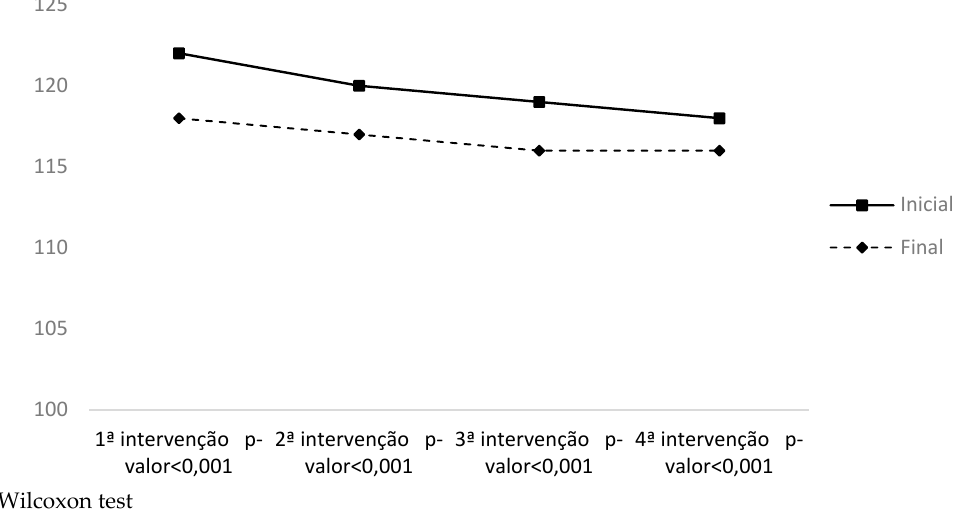
Figure 2. Median values of systolic blood pressure (SBP) before and after the four interventions in the IG (Raja yoga meditation).